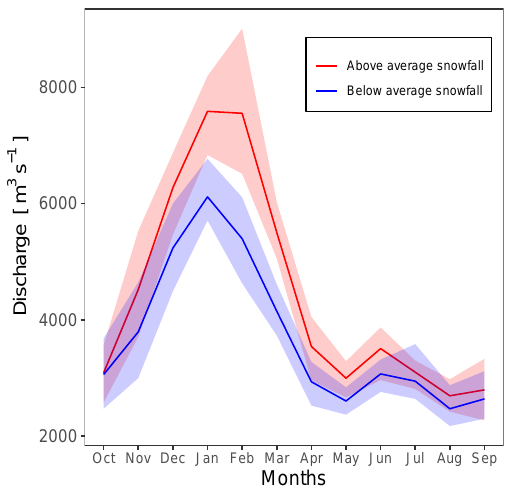
Figure 5. The seasonal cycle of discharge for the years above and below average snowfall. The solid lines are the mean of the 95 th percentile of discharge for each ensemble member and the shaded area represents the spread of the ensemble (between 5 th and 95 th